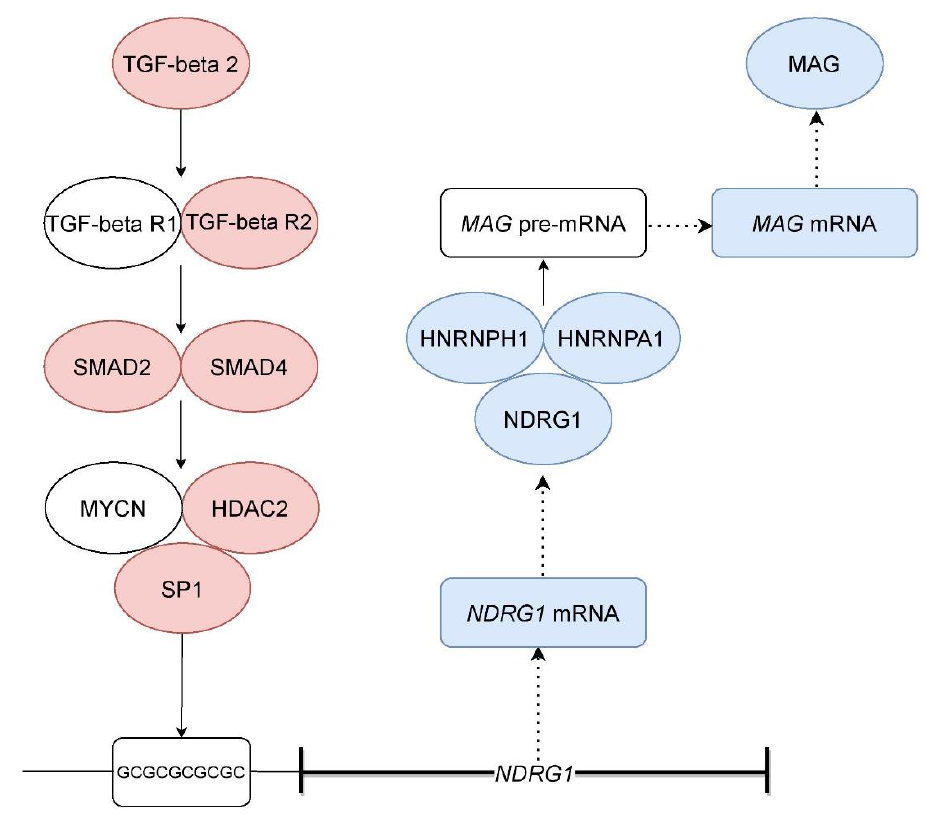
Figure 4. Putative molecular pathway linking TGFB2 up-regulation to the decreased expression of MAG in silent periplaques. In red: proteins encoded by genes that are up-regulated in silent periplaques. In blue: mRNAs down-regulated in silent periplaques (in italics) and proteins encoded by genes that are down-regulated in silent periplaques.